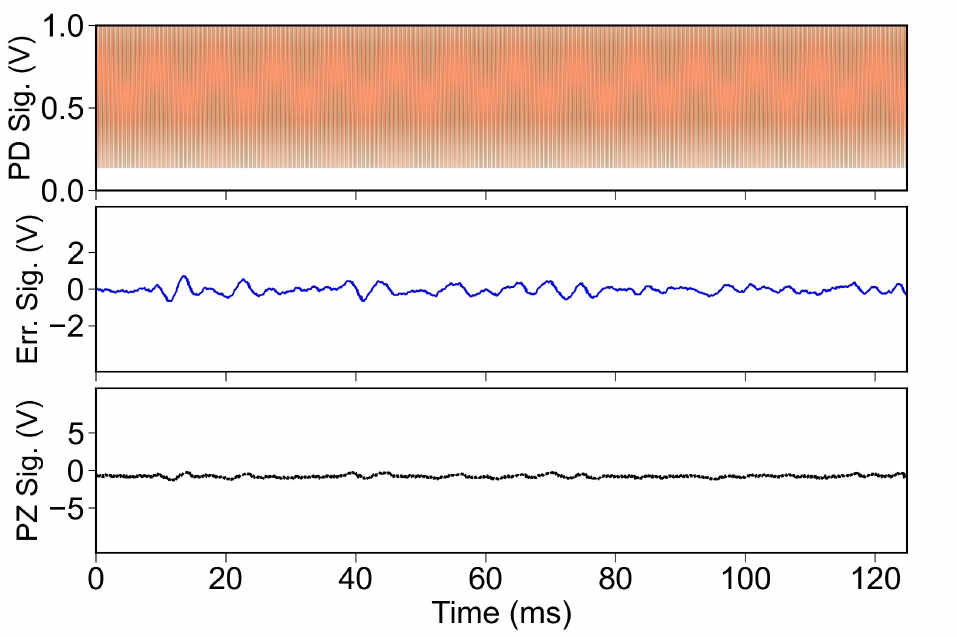
Figure 5. PD and error signals in CW+pulsed